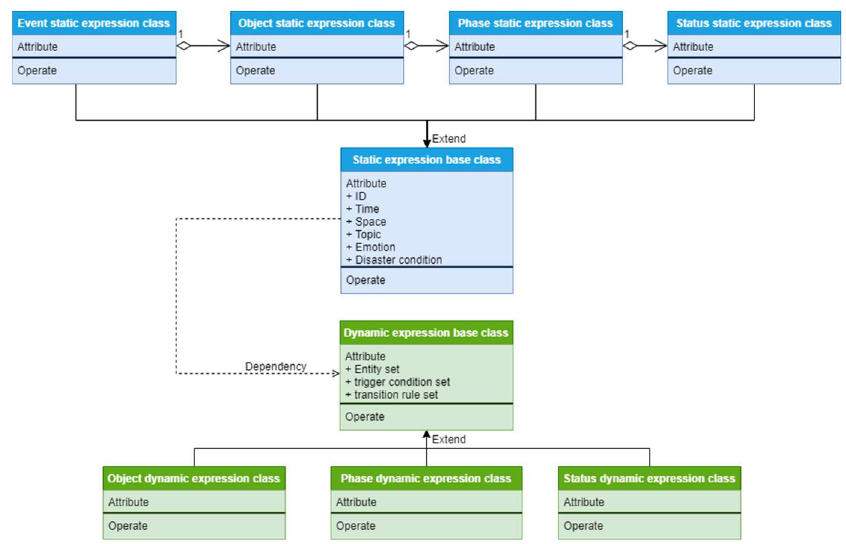
Figure 2. Schematic diagram of the relationship between EMMFPO expression classes.